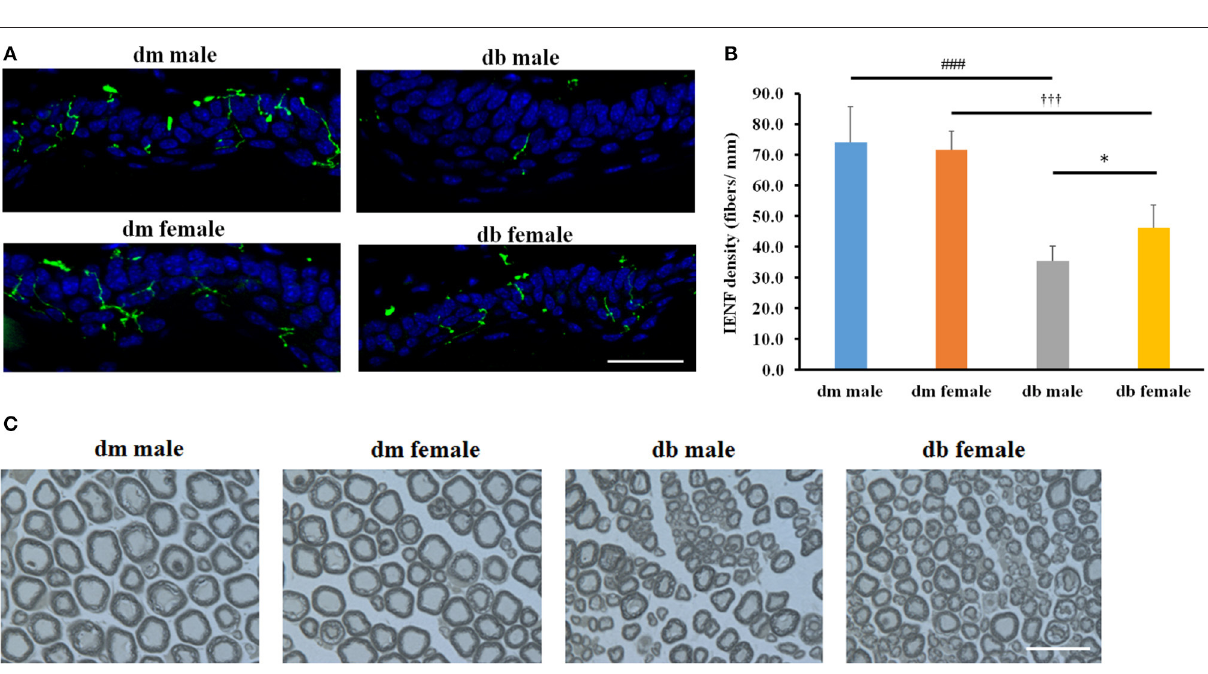
FIGURE 5 | The differences of epidermal innervation and morphometric changes of myelinated sciatic nerves between males and females IENF. Representative immuno-fluorescent images show PGP9.5 staining IENF (green, arrows) and epidermal innervation in the hind plantar paw skin of in mice aged 20 ∼ 30 weeks (A) . Histogram represents the mean number of IENF per site (B) . Representative images of semi-thin toluidine blue-stained transverse sections of sciatic nerves derived from male and female db/db or db/m mice aged 20–30 weeks (C) . * P < 0.05, db/db male vs. db/db female; ### P < 0.001 db/m male vs. db/db male; ††† P